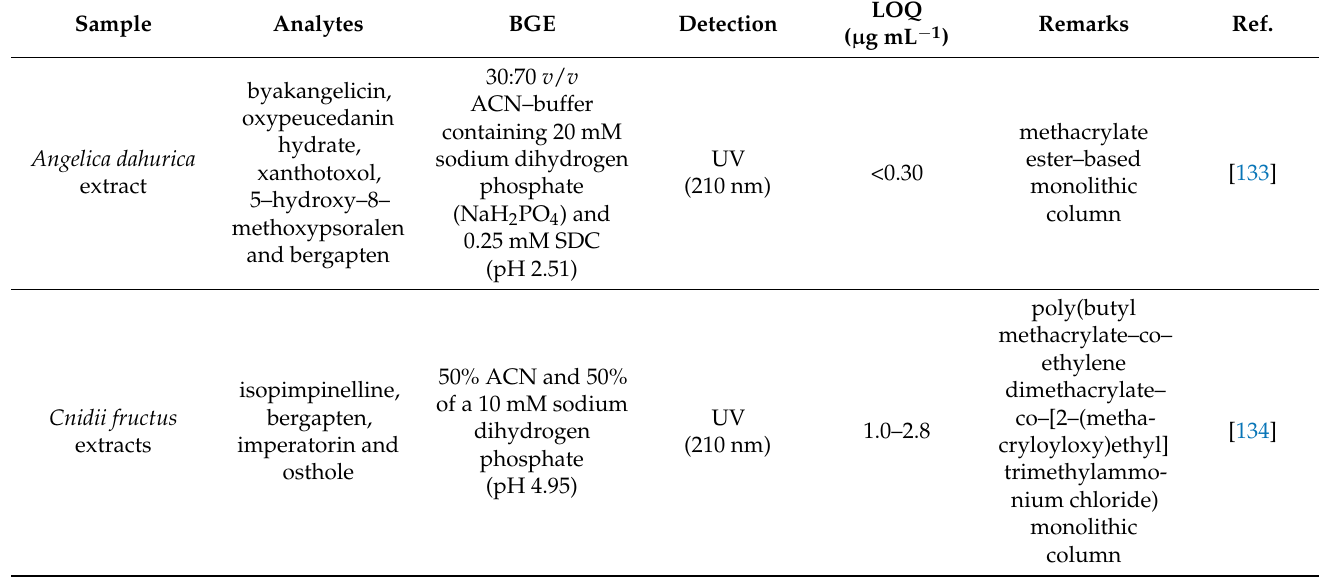
Table 4. Application of capillary